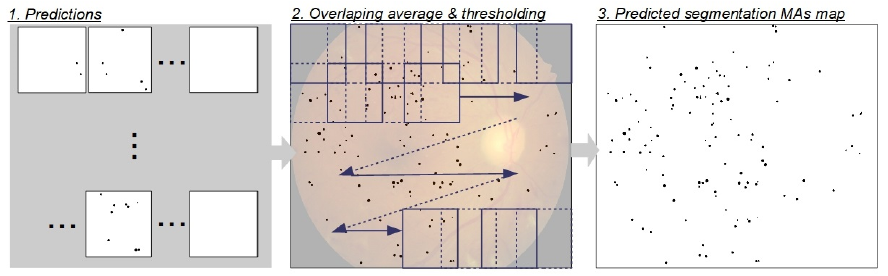
Figure 9. Diagram of the reconstruction of the whole MA segmentation